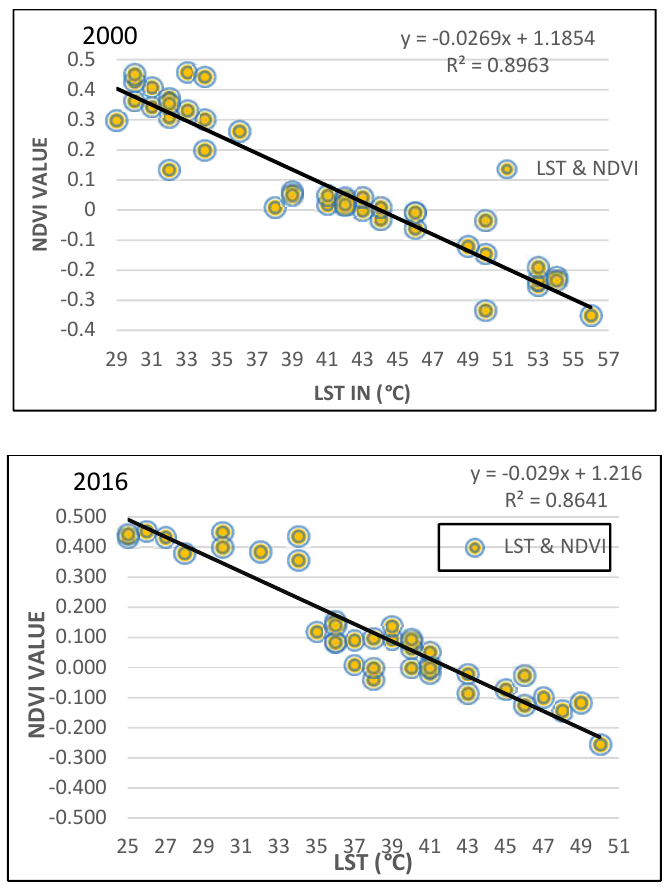
Figure 12. Correlation between NDVI and LST in the period of the study (1990, 2000 to 2016).